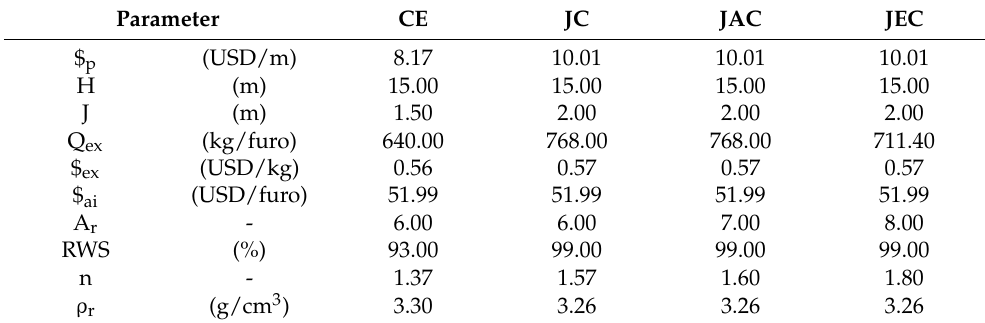
Table 2. Mean parameters used for the model calibration process for drilling and blasting at the truckless mine.